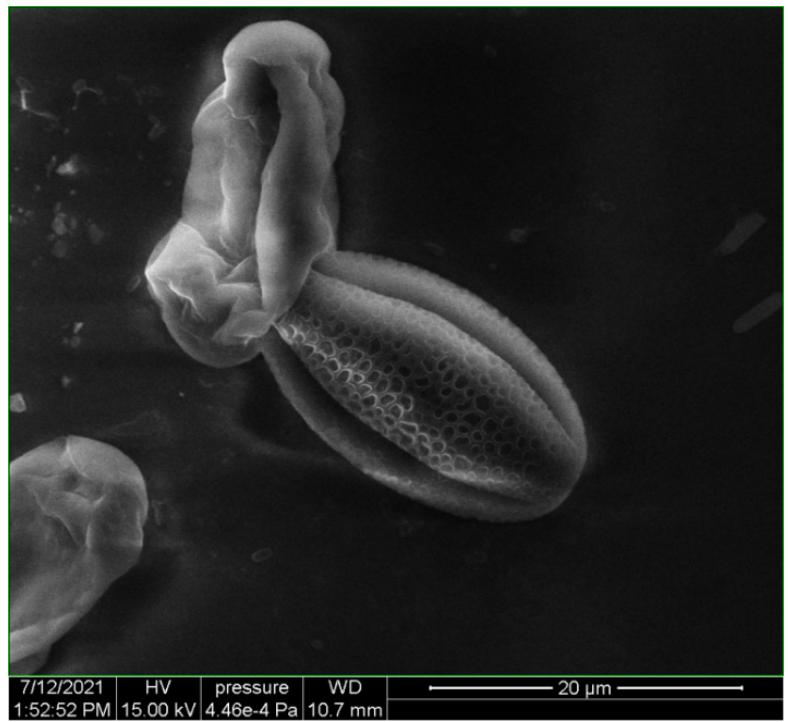
Figure 12. Pollen bags detected in sediment of rainwater collected on 12 May 2020, in Pelinia.